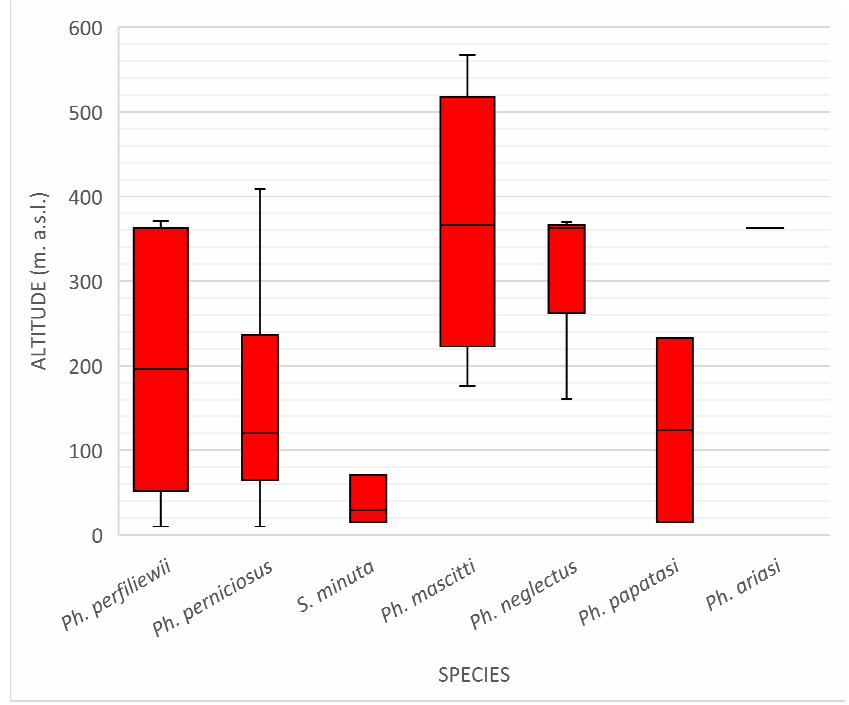
Figure 3. Box diagram describing the altitude range for each sand flies species. Only one specimen of